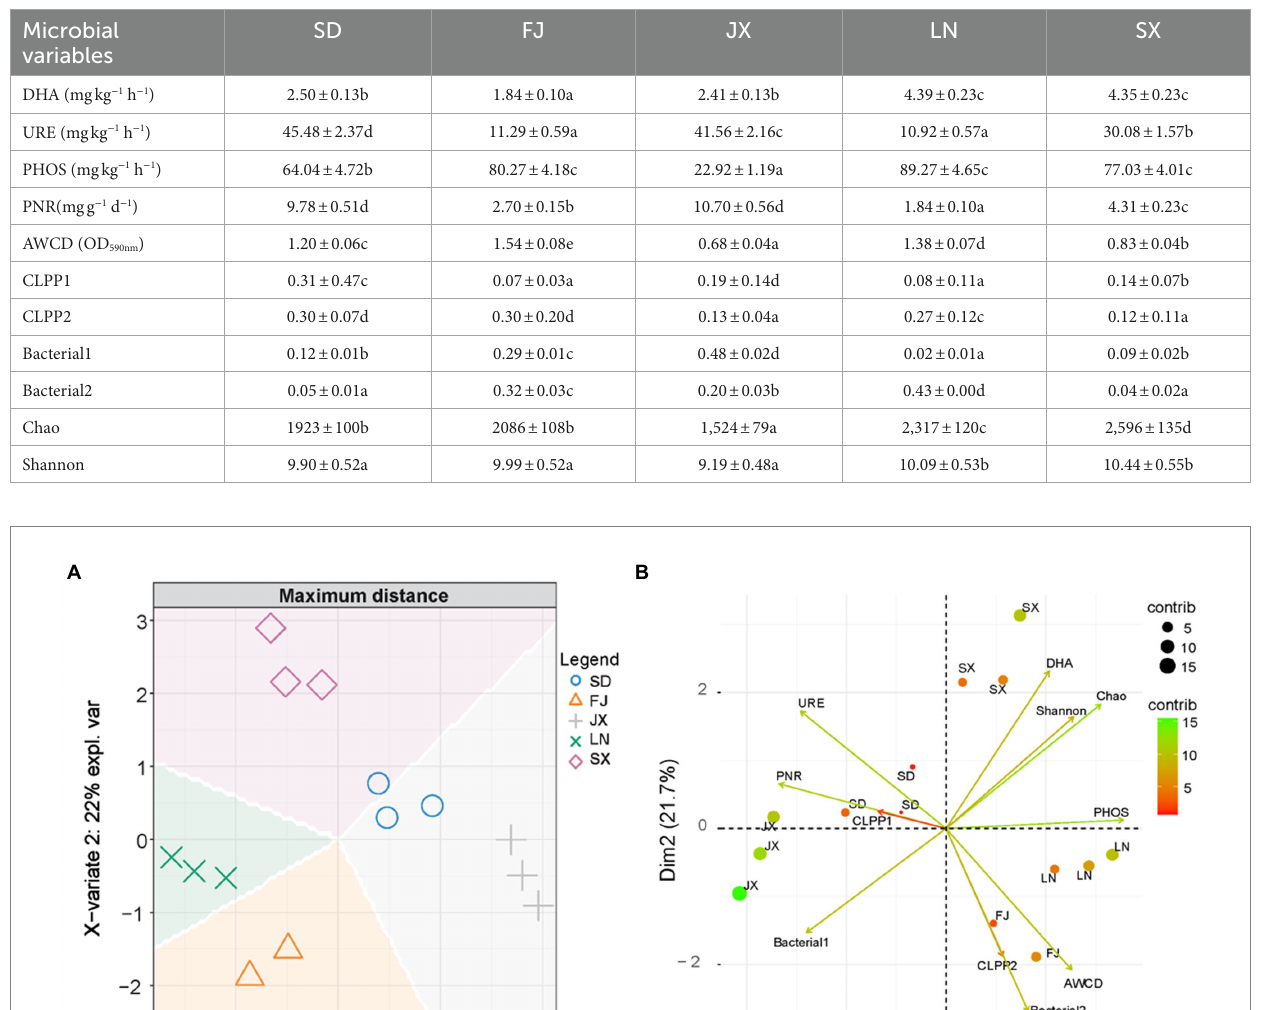
TABLE 2 Microbial variables of five soils (0–20 cm) listed as mean ± standard error ( n = 3). Microbial variables